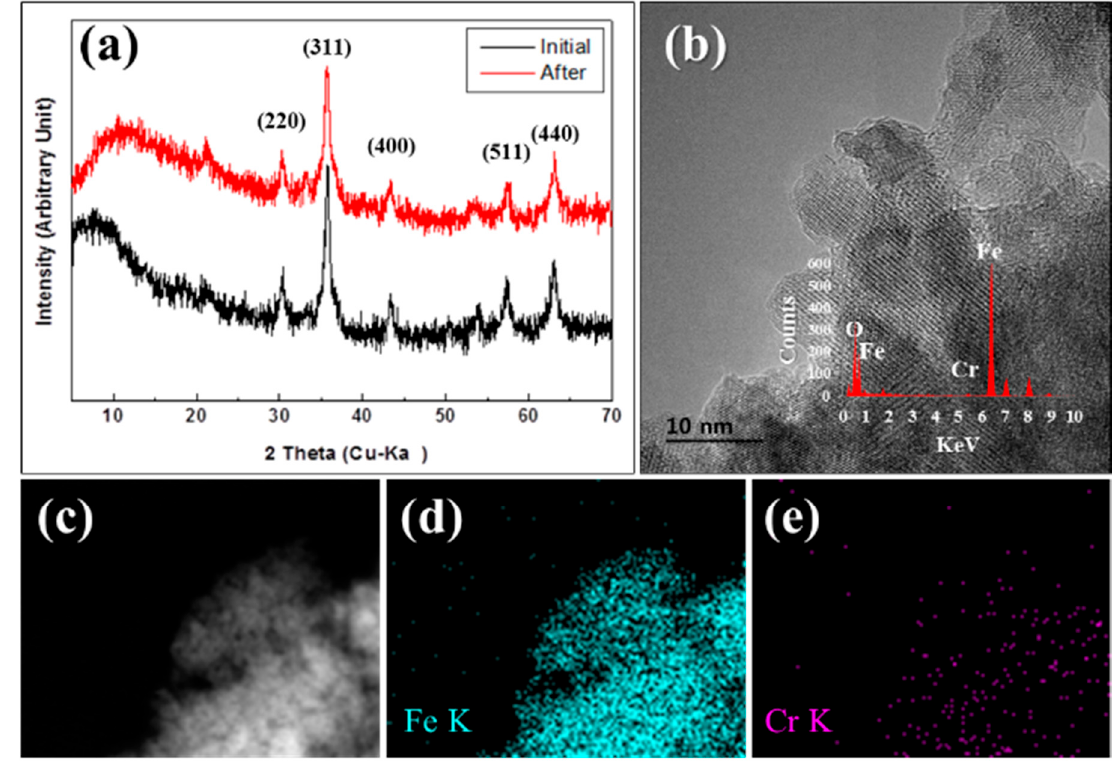
Figure 3. ( a ) XRD patterns, ( b ) TEM-EDS images, ( c ) backscattered electron image, ( d ) STEM-EDS elemental spot map of Fe, and ( e ) STEM-EDS elemental spot map of Cr for BMNs reacted Cr(VI)-contaminated water for 48 h.